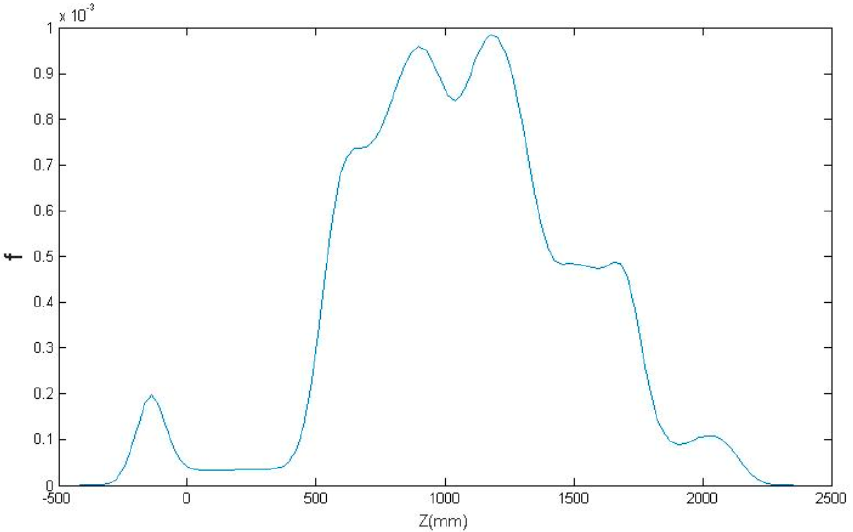
Figure 9. Probability density distribution on the Z -axis.